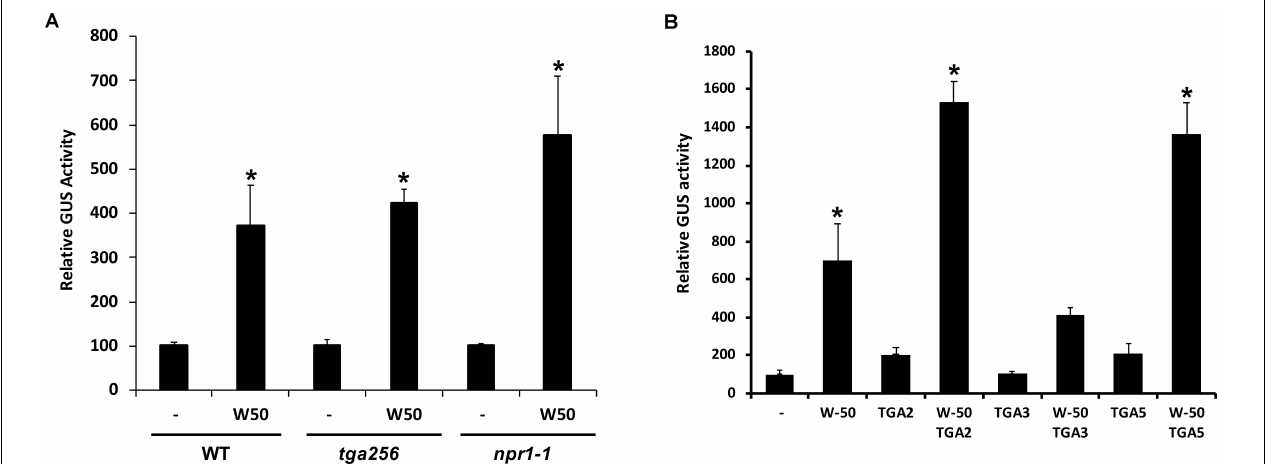
FIGURE 2 | (A) AtWRKY50 induced expression is independent of NPR1 and TGAs. Protoplasts from wild type (WT), tga2-1 tga5-1 tga6-1 triple mutant ( tga256 ) and npr1-1 mutant ( npr1 ) plants were co-transfected with PR1::GUS reporter construct alone (minus sign) or together with expression plasmids containing 35S::AtWRKY50 (W50), as indicated. After incubation GUS activity was measured spectrophotometrically. The bars represent the percentage of GUS activity from triplicate experiments relative to that of the protoplasts co-transfected with the PR1::GUS construct and empty vector control. Error bars represent the SEM. Asterisk ( ∗ ) shows the statistical differences among samples ( p < 0.05). (B) Synergistic effect of AtWRKY50 and TGA2 or TGA5 on PR1 expression. Arabidopsis protoplasts were co-transfected with PR1::GUS reporter construct alone (minus sign) or together with expression plasmids containing 35S promoter-controlled genes encoding AtWRKY50, TGA2, TGA3, TGA5, or combinations, as indicated. After incubation GUS activity was measured spectrophotometrically. Expression levels (%) are given relative to the expression the level without expression plasmid. The bars represent the percentage of GUS activity from triplicate experiments relative to that of the protoplasts co-transfected with the corresponding PR1::GUS construct and empty vector control. Error bars represent the SEM. Asterisk ( ∗ ) shows the statistical differences among samples ( p <